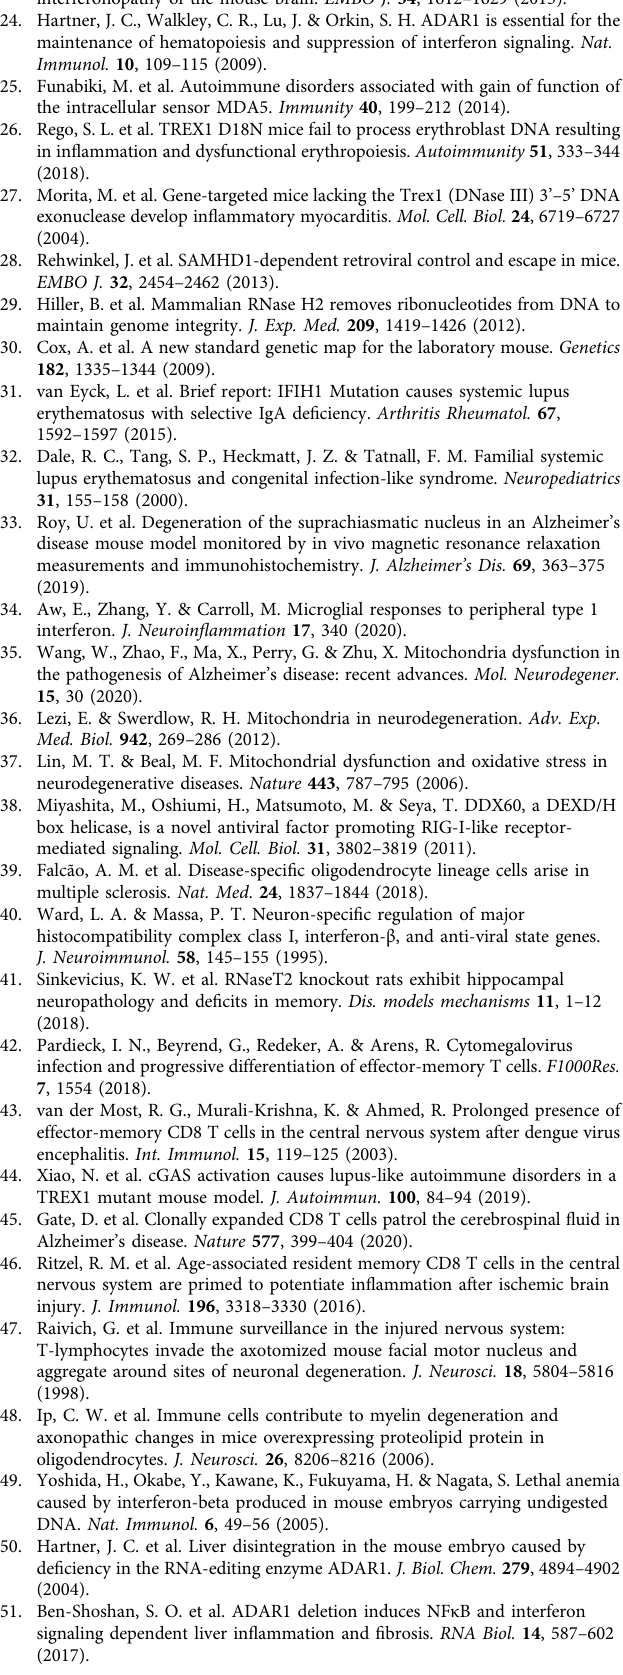
Detailed annotation tables for these datasets are provided in Supplementary Data 1. Mus musculus reference genome (GRCm38.p6) use for single RNA nuclei study is accessible from NCBI GenBank under the accession numbers GCA_000001635.26. Reference sequence for Rnaset2a and Rnaset2b gene are accessible from NCBI GenBank under the accession numbers NM_001083938.3 and NM_026611.2, respectively. Source data are provided with this